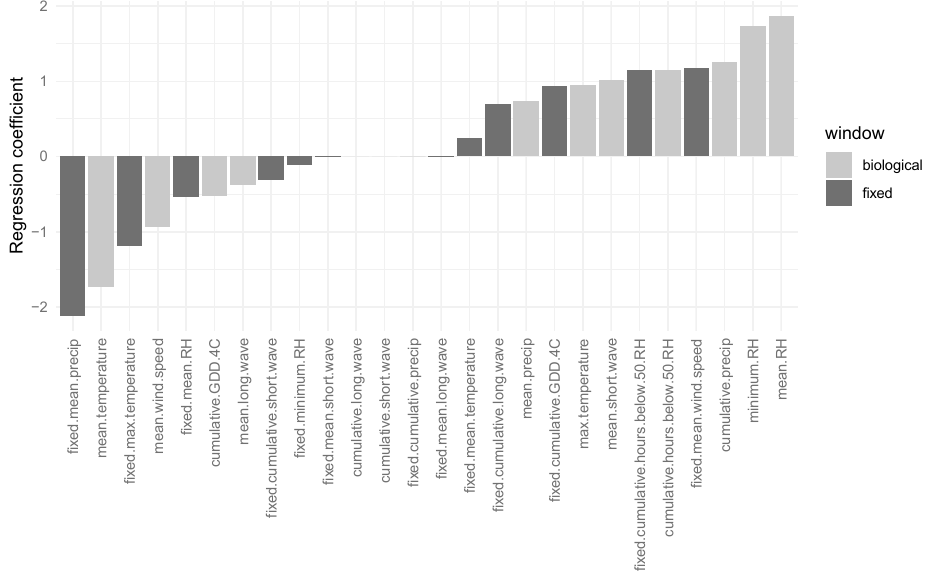
Figure 3. Relationships of weather variables with the environment, genotype by environment interaction, and error residuals on physical dormancy. A Least Absolute Shrinkage and Selection Operator fitted 26 weather variables to residuals. A 100-fold training set identified a prior distribution for the Lasso, λ , that minimized cross-validation error. Aggregate statistics from hourly weather data were calculated as fixed time windows at 30 days prior to the final pod harvest at a site-year (‘fixed’) and biological time windows extrapolated as the date of seed physiological maturity to the date of pod harvest for individual maternal plants (‘biological’). Bars show the magnitude of the contribution of weather variable to environment, genotype by environment, and error residuals. Smoothing splines did not show strong relationships between weather variables and PY residuals. The most important six weather variables in the Lasso model (Figure 3; fixed mean precipitation, mean RH, mean temperature, minimum RH, cumulative precipitation, and fixed maximum temperature) showed weak visual relationships with PY (Figure 4). Seeds that dried in conditions with high mean and minimum RH, low mean and maximum temperature, and high precipitation weakly grouped with lower PY (Figure 4).